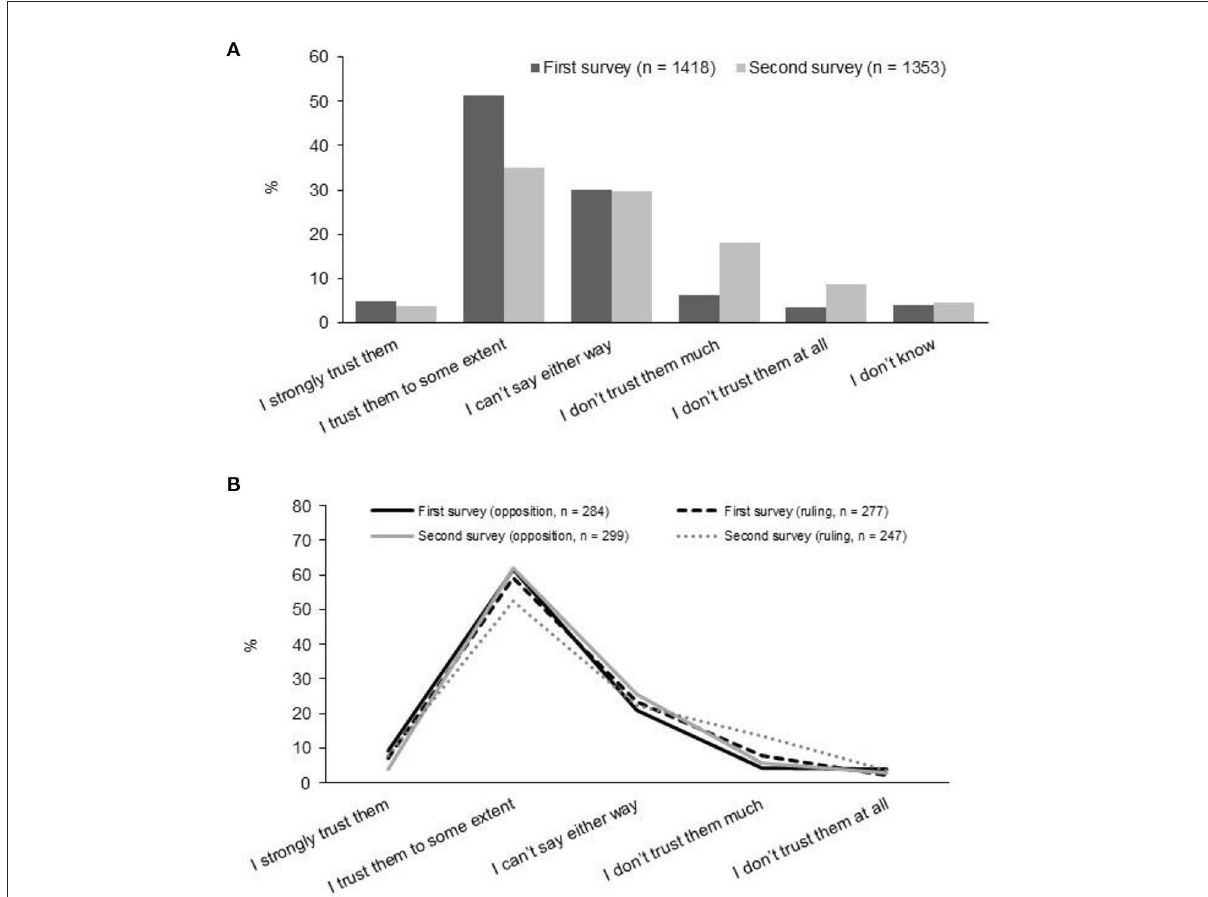
FIGURE3 (A) Level of trust in researchers affiliated with a university and (B) level of trust based on support for different political parties. “I don’t know” responses were not included in this